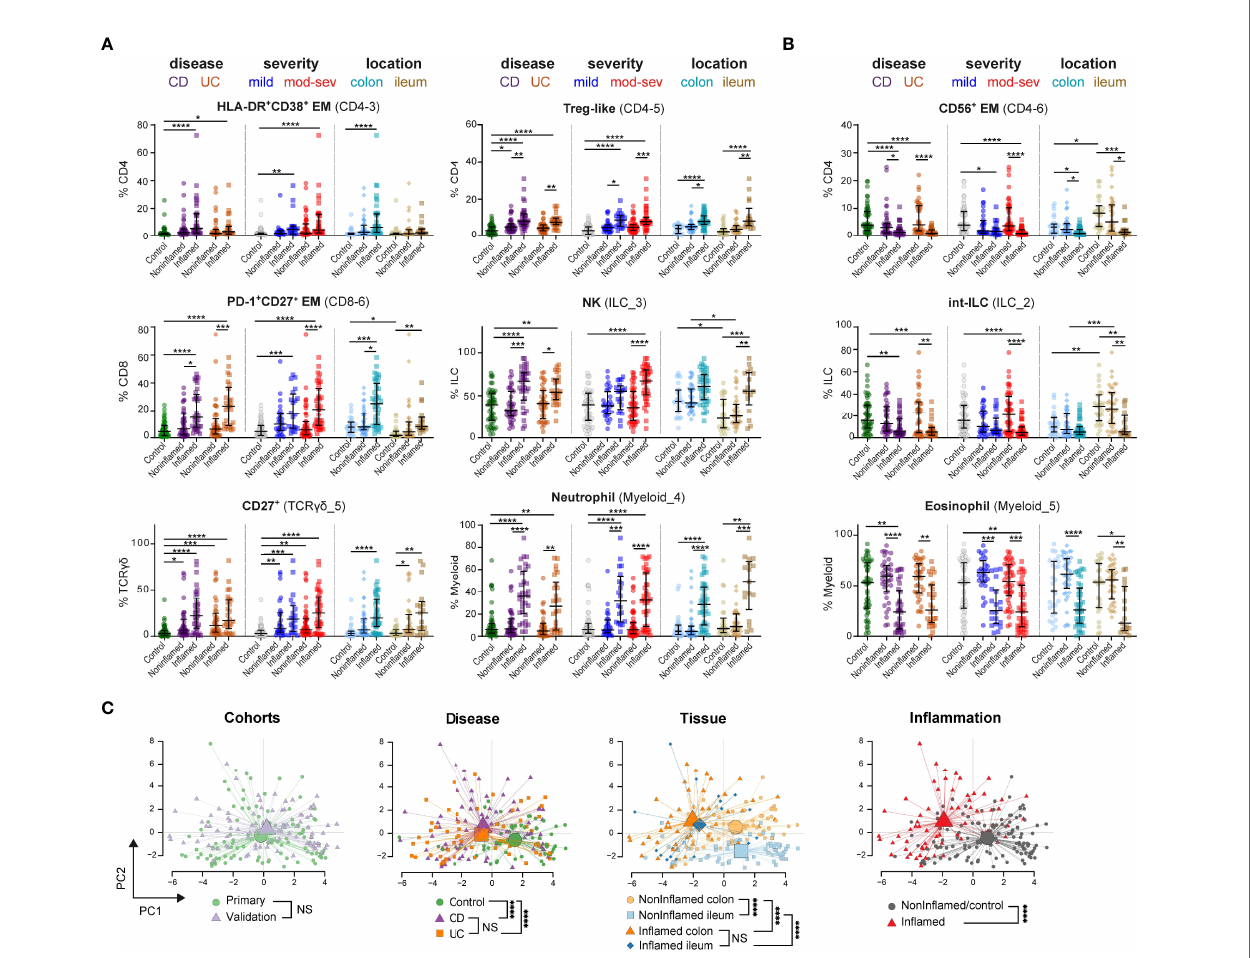
FIGURE 4 | Immune subset signatures strati fi ed for disease subtype, severity and intestinal location. Graphs show frequencies (as % of immune lineage) of indicated cell subsets from (A) network 2 and (B) network 1 in each intestinal biopsy from 53 controls, 76 nonin fl amed-IBD samples and 59 in fl amed-IBD samples from the primary and validation cohorts combined, strati fi ed for disease subtype (CD, Crohn ’ s disease; UC, ulcerative colitis), disease severity (mild and mod-sev, moderate- to-severe) and intestinal location. Bars indicate the median with interquartile range. *p ≤ 0.05, **p ≤ 0.01, ***p ≤ 0.001, ****p ≤ 0.0001, Kruskal-Wallis test for multiple groups. (C) PCA (% of CD45 + cells) of 44 immune cell subsets for 188 intestinal samples. Every dot is an intestinal sample and colors show the cohort, disease subtype, tissue location and in fl ammation state. Lines connect samples to the centroid of each group. ****p ≤ 0.0001, Hotelling ’ s two-sample T2-test for PCA-reduced sample groups. NS indicates not signi fi